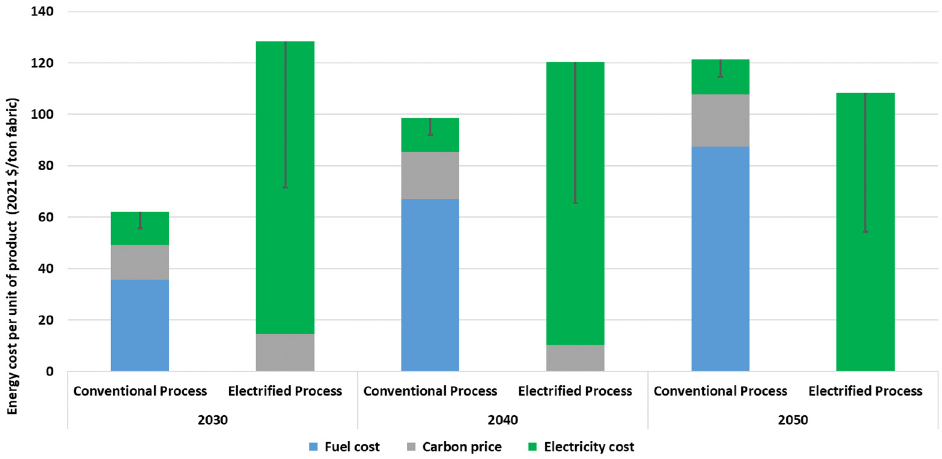
Figure 18. Energy cost per unit of production for conventional and electrified dyeing process in China.